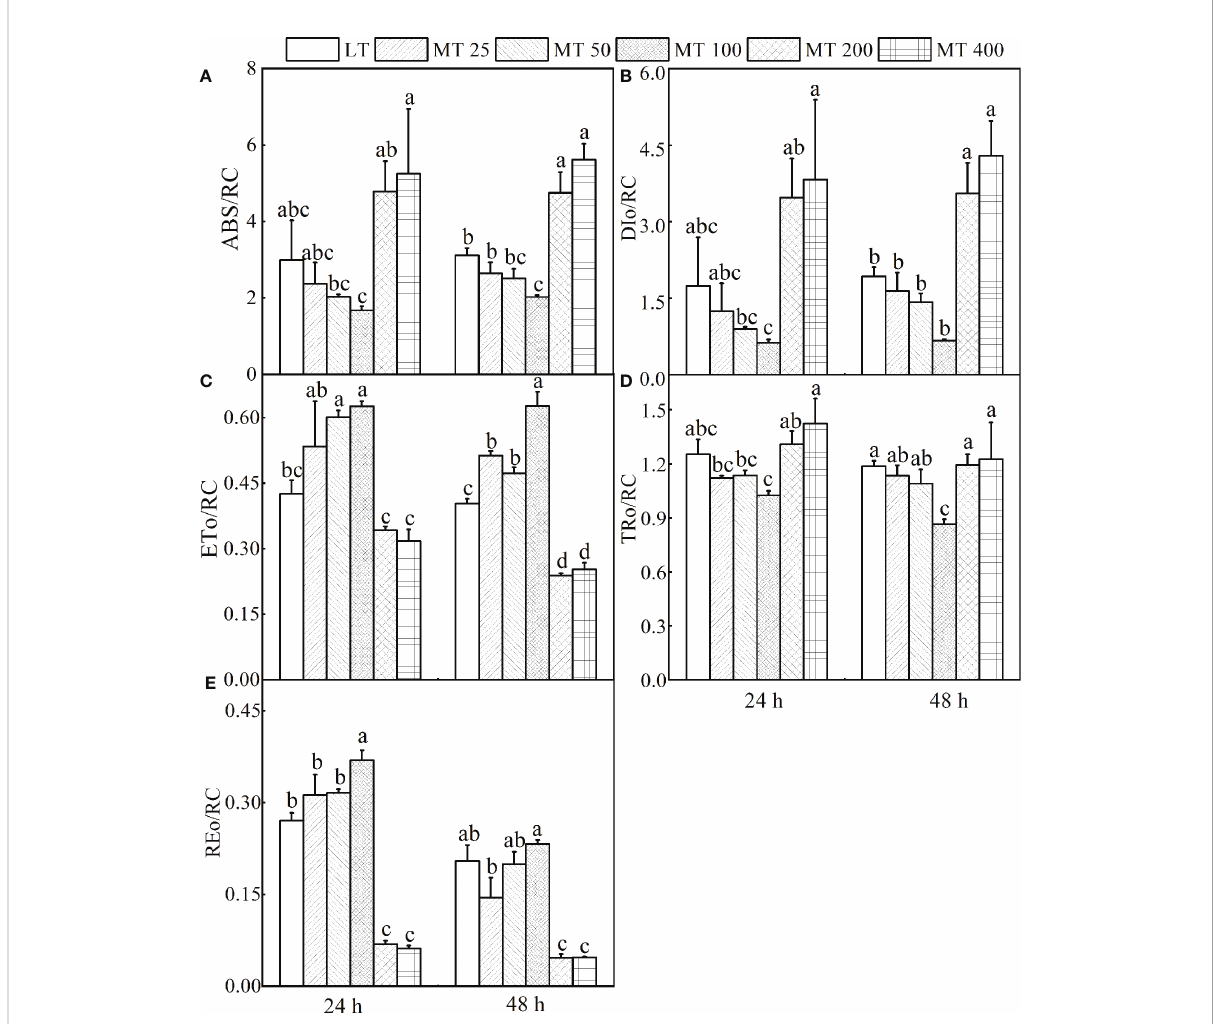
FIGURE 6 Parameters derived from OJIP transients of cucumber plants treated with different concentrations of melatonin (MT) under low temperature stress. (A) The energy absorbed by each active reaction center (RC). (B) The energy dissipated by each active RC. (C) The energy fl ux transferred by each active RC. (D) Excitation energy fl ux captured by each active RC. (E) The electron transport from QA- to the PSI electron acceptors by each RC. The values were represented by the means ± SE. The same letters denoted that there is no signi fi cant difference at P < 0.05 according to Duncan's